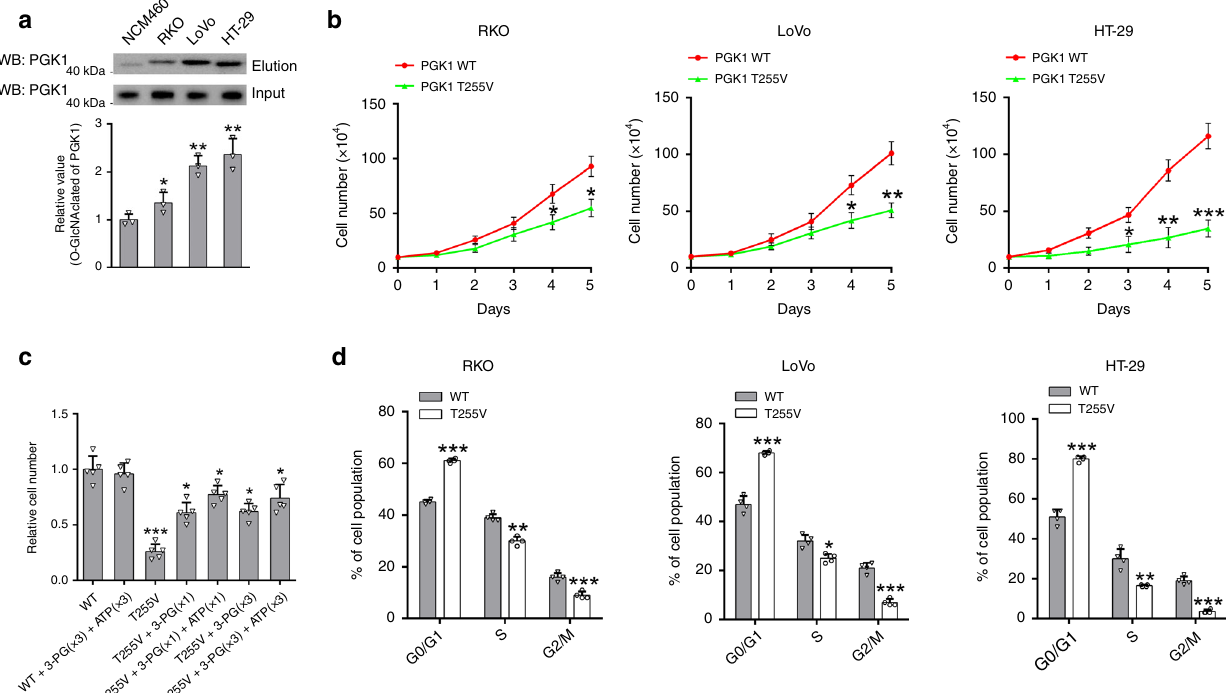
Fig. 4 O-GlcNAcylation of PGK1 is important for colon cancer cell proliferation. a Analysis of PGK1 glycosylation in a panel of three human colon cancer cell lines and a normal colon cell line NCM460. b Cell proliferation of PGK1 WT or T255V rescue cells. In RKO, LoVo and HT-29 cells, endogenous PGK1 was depleted with shRNA targeting PGK1, and then rescued with ectopic expression of PGK1 WT or PGK1 T255V, which is resistant to shRNA targeting. c Cell proliferation of PGK1 WT or T255V rescue HT-29 cells in the presence of various 3-PG and ATP concentrations. d Cell cycle analysis of PGK1 WT or T255V rescue RKO, LoVo and HT-29 cells. Error bars denote the means ± standard deviations (SD). Statistical analyses were performed by